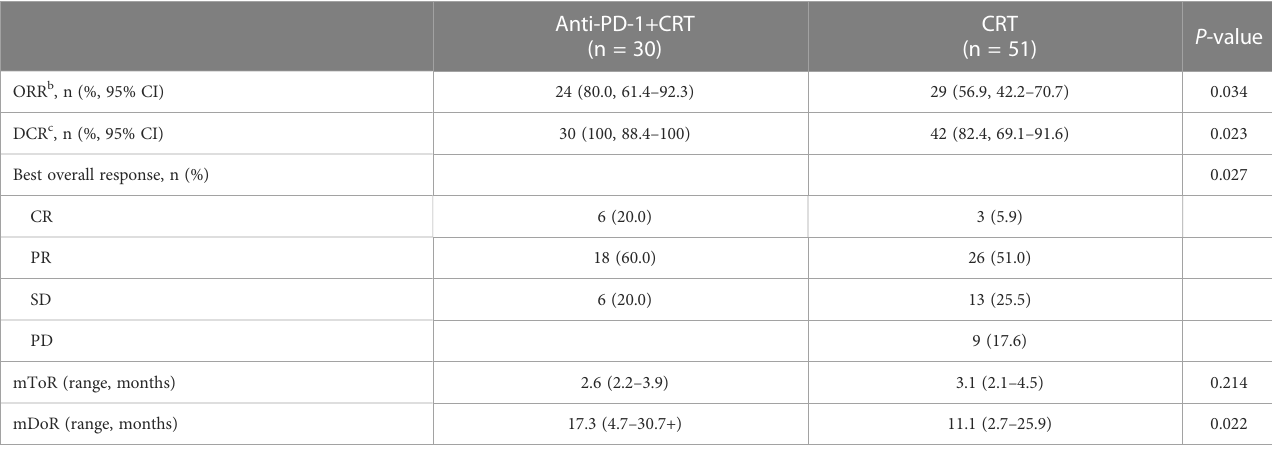
TABLE 2 Tumor response to treatment.